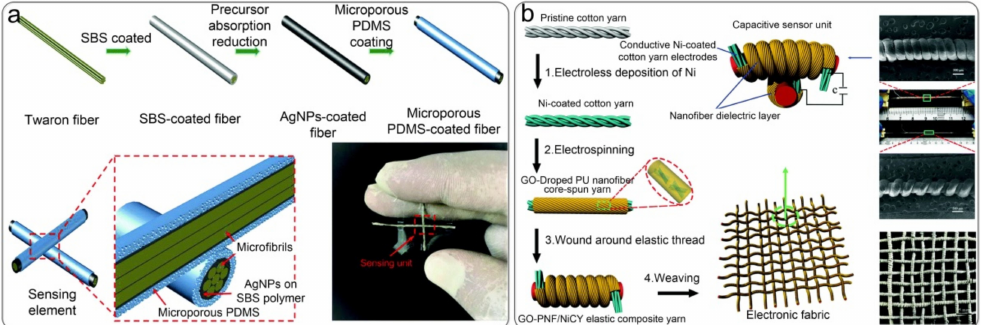
Figure 8. Capacitive pressure sensor based on the yarn devices. ( a ) Coating microporous PDMS elastomer dielectric on conductive fibers to prepare a capacitive pressure sensor. Reproduced with permission from Ref. [112]. Copyright 2017 Royal Society of Chemistry. ( b ) Retractable capacitance sensor array weaved by electrospun nanofiber-coated yarn. Reproduced with permission from Ref. [136]. Copyright 2017 Royal Society of